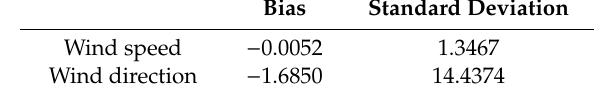
Table 1. ECMWF wind field data and TAO sea surface wind velocity data statistical